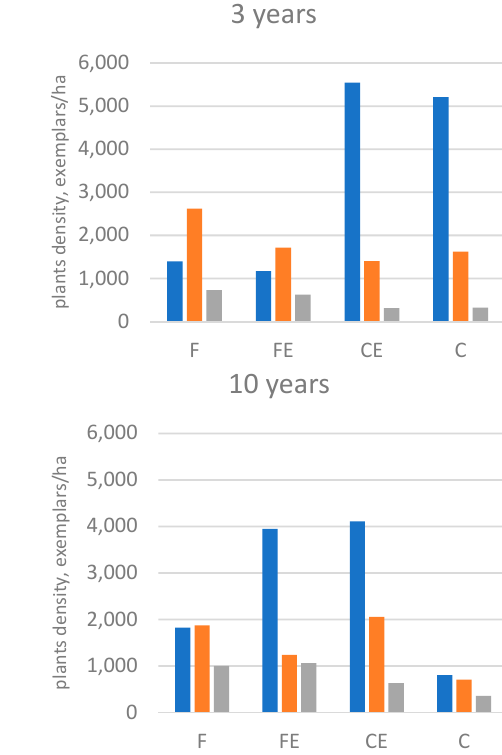
Figure 3. Amount of woody regeneration and understory in the clear-cut adjoining the forest edge in different cardinal directions: northern, eastern, southern, western. Letters indicate differences between means (based on the anal- ysis of variance).